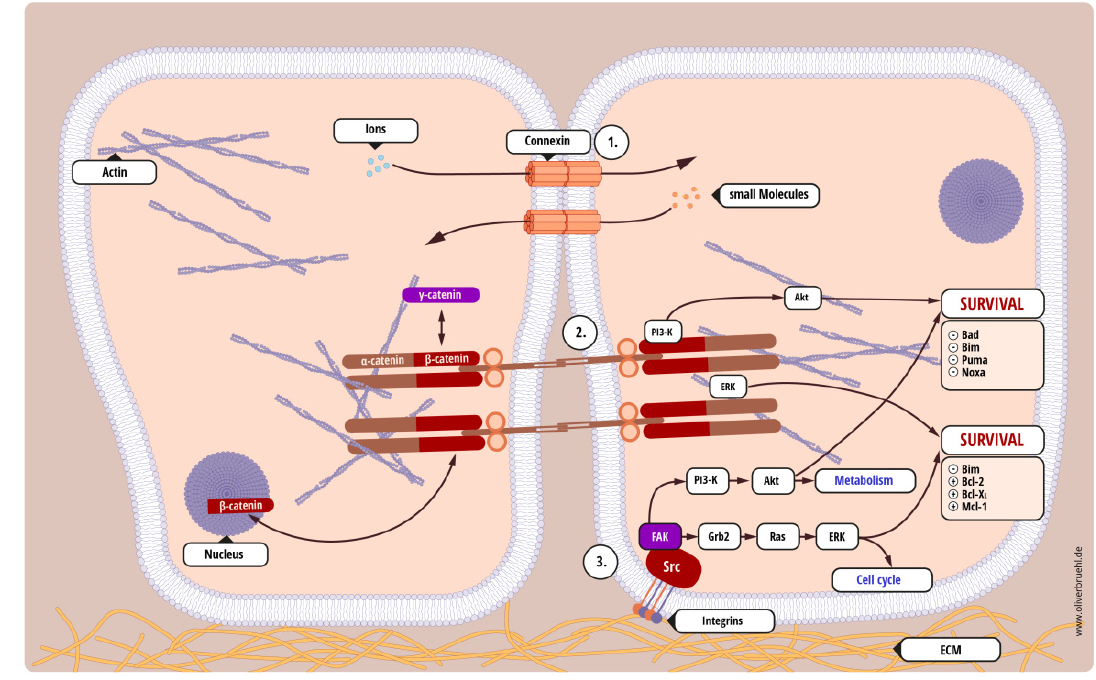
Figure 2. The tumor’s interaction with its solid microenvironment. Three of the five common forms of adhesions are depicted here and their role in cell death prevention is highlighted (expanded from [40]): ( 1 ) Gap junctions, aqueous channels consisting of connexins, through which ions and small molecules can be exchanged between adjacent cells. Generally, they are considered more in terms of cell-cell communication rather than cell-cell adhesion, however, we previously showed both that gap junctions contribute to glioblastoma cell-cell adhesion and, by diluting the apoptotic signal, reduce cell death [28]; ( 2 ) Adherens junctions are not only contacts between cells, but also anchorage points to the cytoskeleton. They consist of plasma membrane spanning cadherins and adjacent cadherin interactions on the plasma membrane lead to the formation of a zipper-like structure which provides a strong adhesive link between cells. In addition, components of the adherens junctions not only mediate cell-cell adhesions, but are also involved in the regulation of signaling cascades, in particular the Wnt pathway; ( 3 ) Focal adhesions are links between the extracellular matrix and the actin cytoskeleton. Their dynamic regulation plays an important role in cell motility, while there are also sites of origin for (a) intracellular survival signals and (b) extracellular cues for microenvironment remodeling. As example, we show in detail two survival pathways that are activated by adherens junctions and focal adhesions, the Raf/MEK/ERK pathway and the PI3-K/Akt signaling cascade (see Figure 3). Note that ( − ) indicates reduced, while (+) stands for increased protein activity. Not shown are desmosomes, which act as tethering points for intermediate filaments, and tight junctions, which form a boundary between apical and basal domains of the plasma membrane. While the former are usually exclusively discussed in terms of reduced expression during metastasis [45], the role of tight junctions is more controversial, as its components either found to be up- or down-regulated in cancers [46]. Of note, PTEN, the negative regulator of PI3-K/Akt signaling also regulates tight junctions